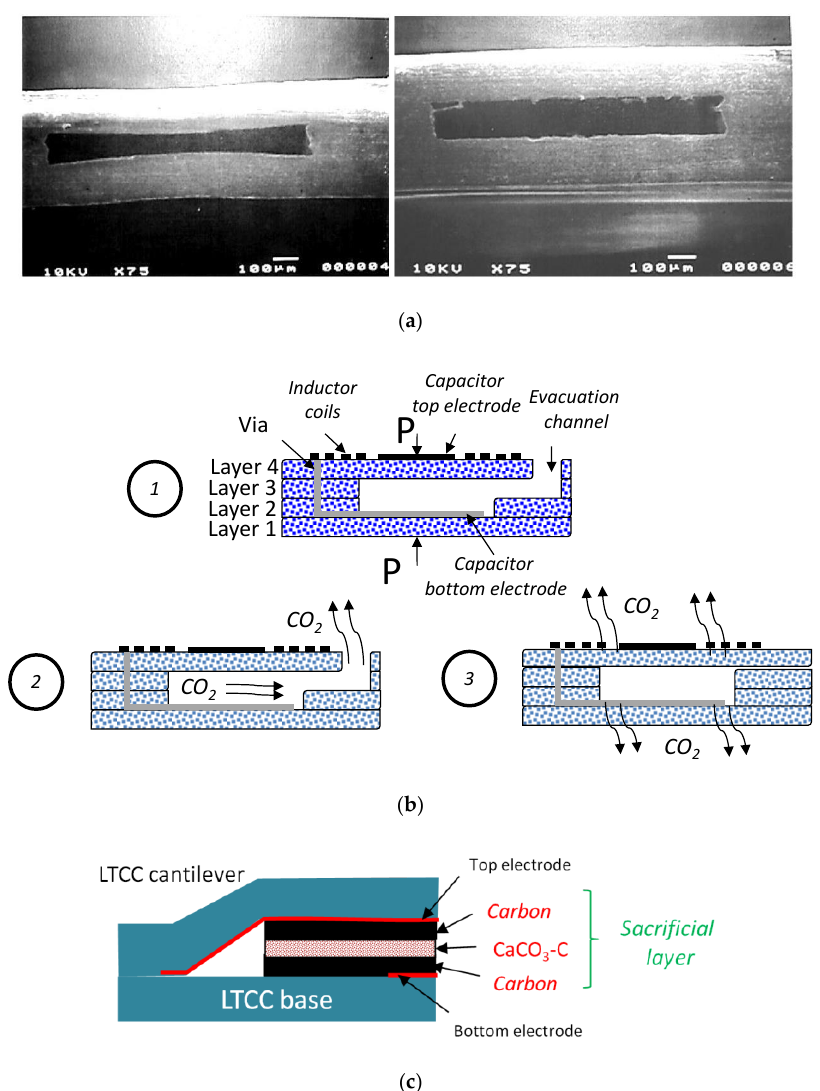
Figure 1. LTCC (low-temperature co-fired ceramic) ceramic Micro-ElectroMechanical Systems (MEMS). ( a ) Photograph of a cavity after sintering without (left) and with carbon black paste (right) reproduced with permission from [11] copyright 2001 Elsevier. ( b ) Scheme of a pressure sensor inspired from Dai et al. [20]: 1. Principle; 2. CO 2 evacuation during the sintering through the dedicated channel or 3. Through the porosity. ( c ) Scheme of a cantilever force sensor (capacitive principle) fabricated using a sandwich sacrificial layer (inspired from Fournier et al. [21]).